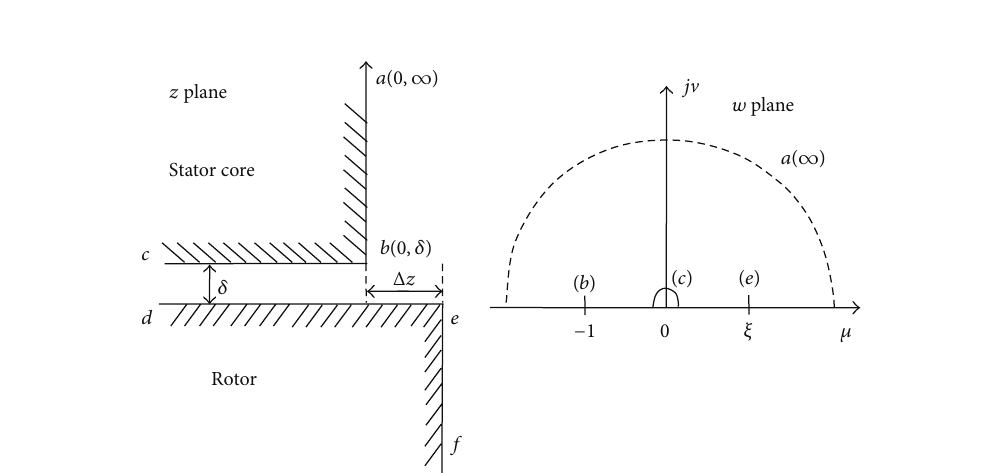
Figure 1: Two kinds of AAGE: (a) static and (b) dynamic.